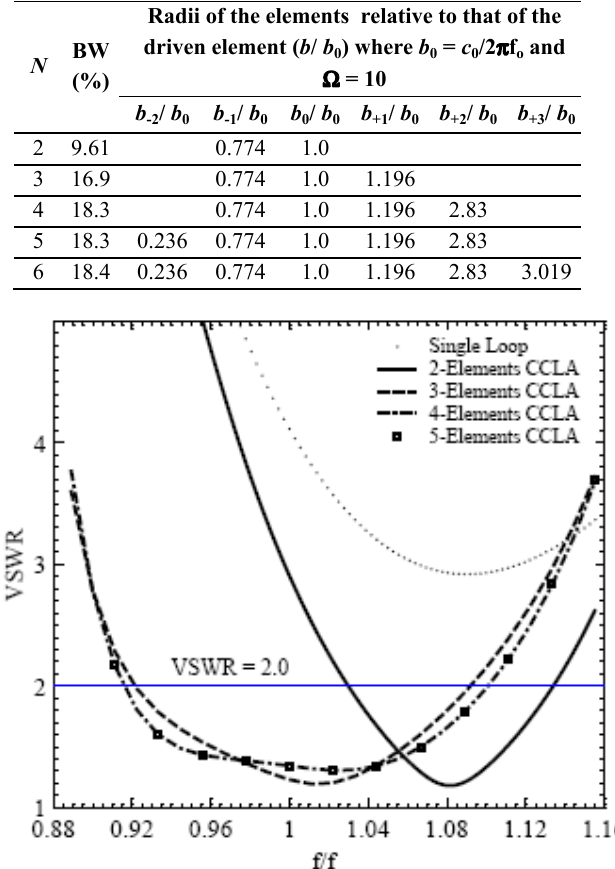
Figure 5: Comparison of VSWR for best bandwidth of different CCLAs with that of a single loop. The thickness parameter for each loop is Ω = 10.